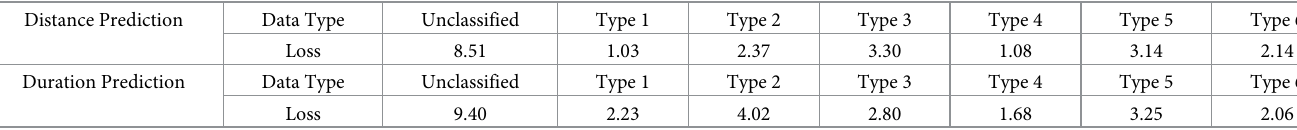
Table 3. The loss value of lane-changing duration and distance prediction